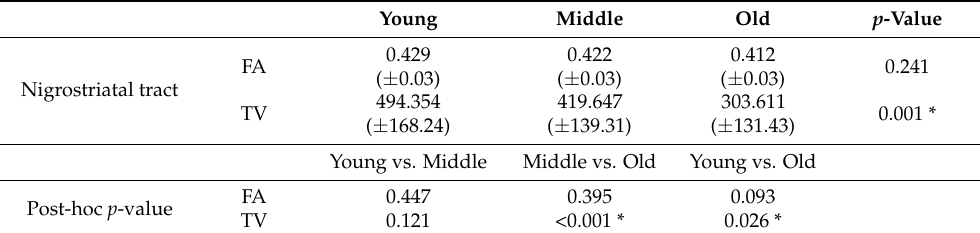
Table 2. Mean values of diffusion tensor tractography parameters of the nigrostriatal tracts accord- ing to sex.